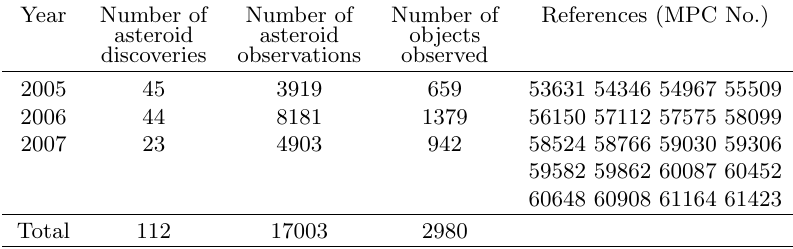
Table 1. Distribution of discoveries of asteroids and the numbers of astrometric observations of asteroids (both new and known) at the Mol_etai Observatory in 2005{2007. Year Number of Number of Number of References (MPC No.) asteroid asteroid objects discoveries observations observed 2005 45 3919 659 53631 54346 54967 55509 2006 44 8181 1379 56150 57112 57575 58099 2007 23 4903 942 58524 58766 59030 59306 59582 59862 60087 60452 60648 60908 61164 61423 Total 112 17003 2980